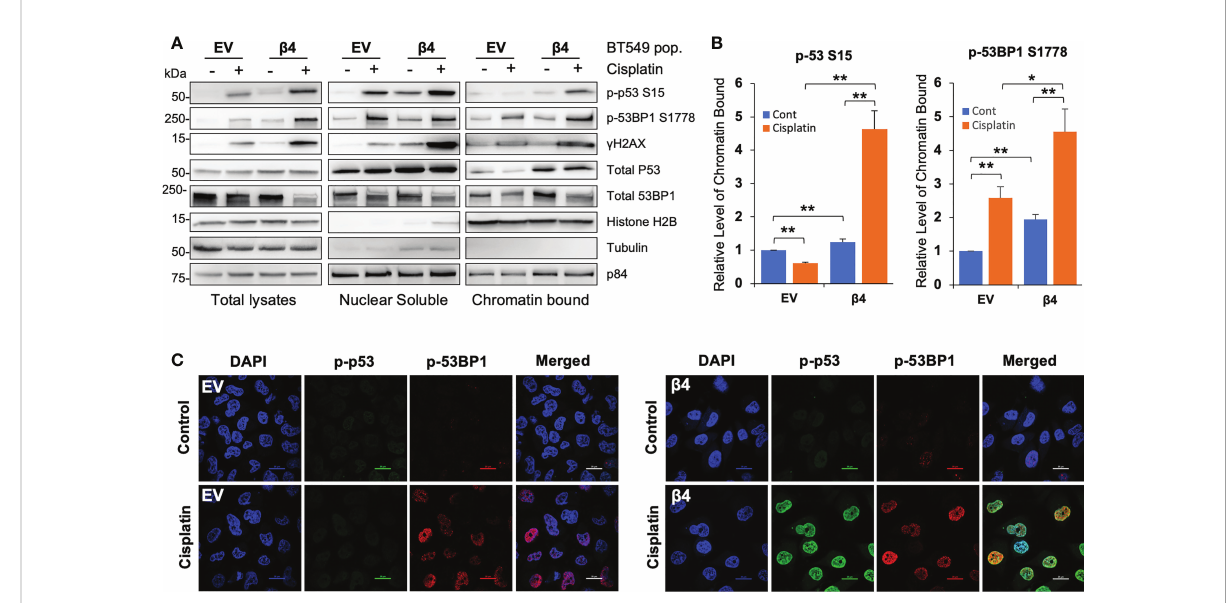
FIGURE 3 Integrin a 6 b 4 promotes recruitment of p53 and 53BP1 to chromatin. (A) BT549 cells (EV and b 4) were plated on laminin-1 and treated with 10 m M cisplatin for 24h. Subcellular protein fractions were immunoblotted with DDR proteins as indicated. Tubulin was used as the marker for total protein, p84 was used to mark nuclear fractions, and Histone H2B used to mark chromatin fractions. (B) Fold changes in noted phosphorylation in chromatin bound from (A) are reported after normalization to Histone H2B and reported relative to BT549-EV control treatment. (C) Cells treated as in (A) were immunostained for phospho-p53 S15 and phospho-53BP1 S1778, as indicated, using DAPI as a counterstain (scale bars, 20µm). *p < 0.05, **p <